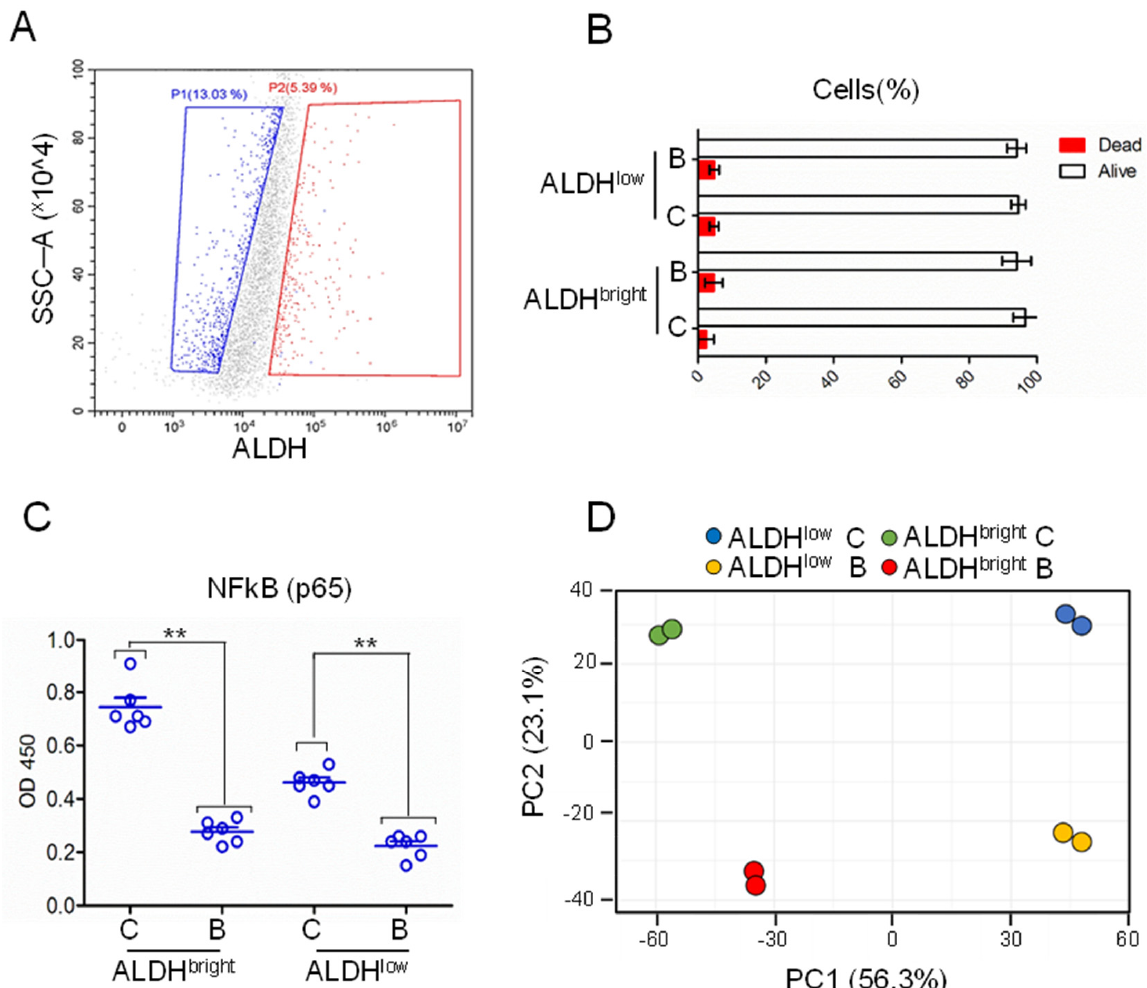
Figure 2. Purification of mesothelioma ALDH bright cell subpopulations : ( A ) representative dot plots of NCI-H2595 MPM cells gated into ALDH low (left) and ALDH bright (right) cell subpopulations based on their ALDH activity. ( B ) Viability assay (incorporation of Sytox Blue dead cell stain) of the purified cell subpopulations treated with ctrl ( C ) (0.05% DMSO, 7 h) or with butein ( B ) (10 micromol/L, 7 h) after 2 h recovery from the FACS-based enrichment. No statistical difference was noted among all four treated samples in terms of percentage of dead cells. ( C ) Levels of p65 NFkB bound to a synthetic oligonucleotide from nuclear extracts of the purified cell subpopulations treated as indicated in ( C ) ( n = 6). ELISA assay. Statistics: ** p < 0.01. ns = not significant. ( D ) PCA plots showing the distribution of the cell subpopulations considered in ( B ), based on the levels of 924 genes significantly modulated according to ALDH status and treatment.